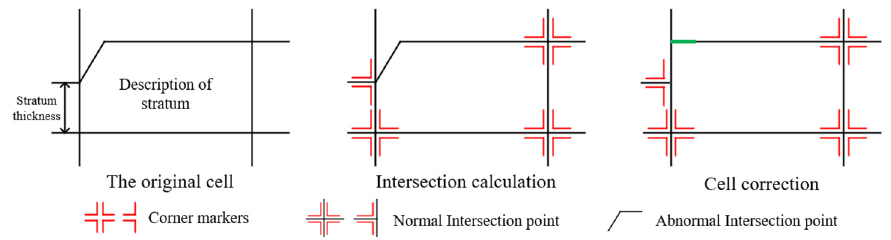
Figure 5. Method and flow of cell positioning.